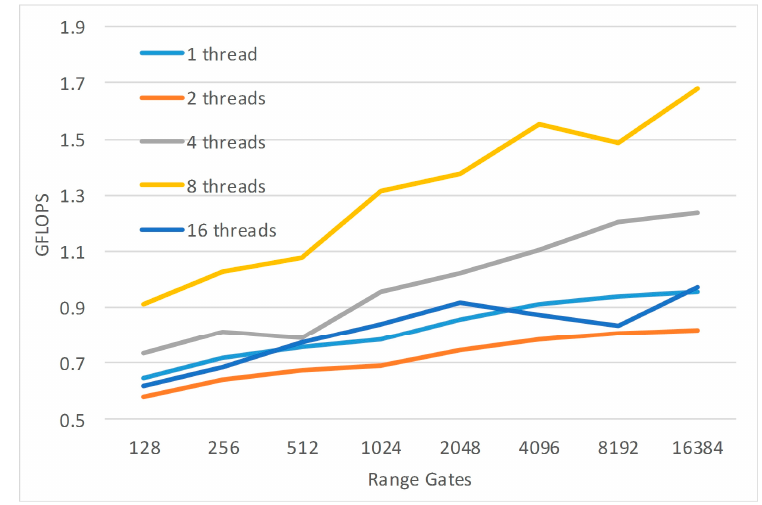
Figure 19. Doppler processing performance using OpenCL.